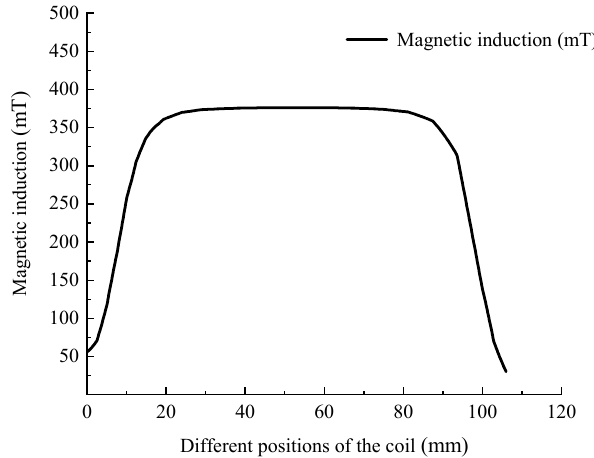
Figure 7. Magnetic induction intensity inside the coil.